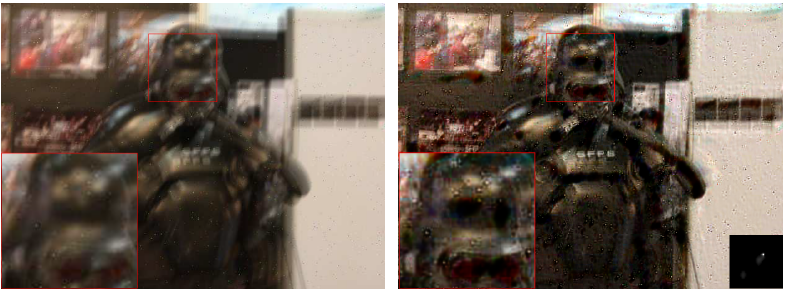
Figure 21. Limitation of the proposed